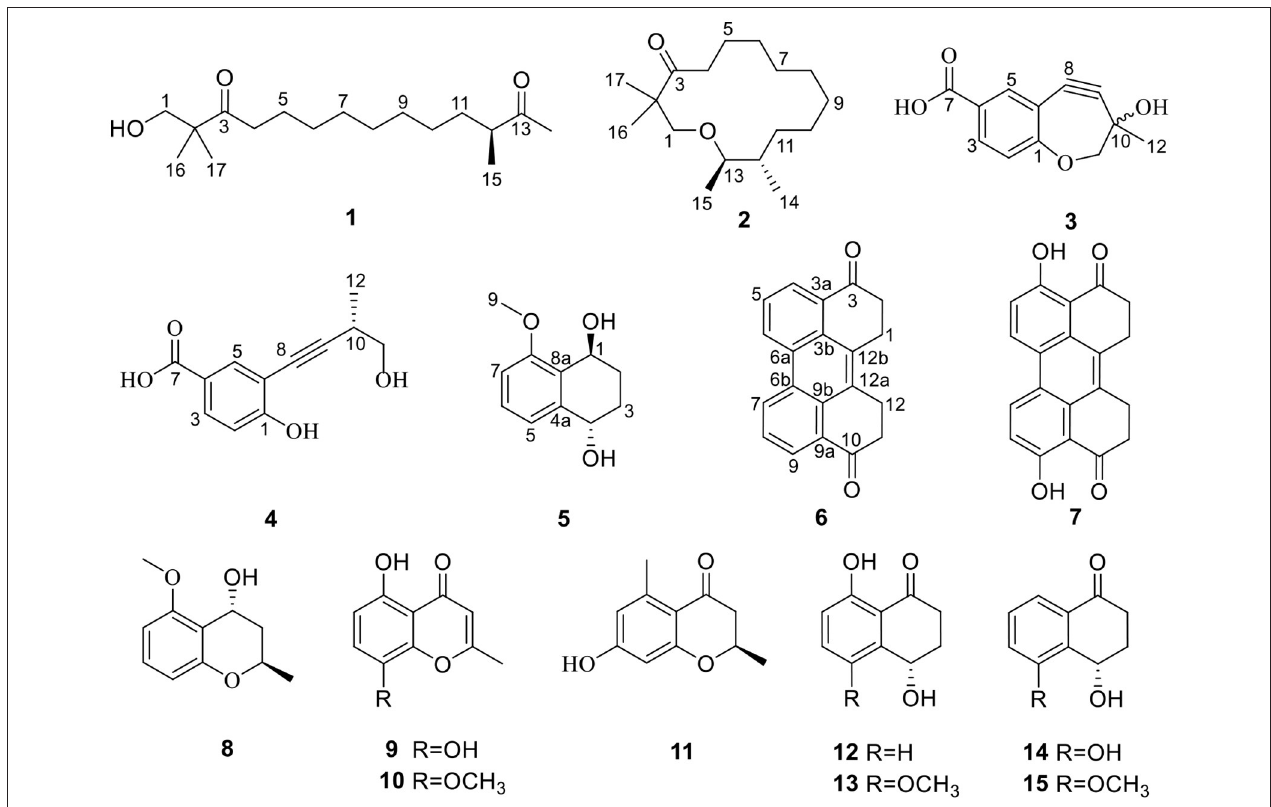
FIGURE 1 | The structures of 1-15 .